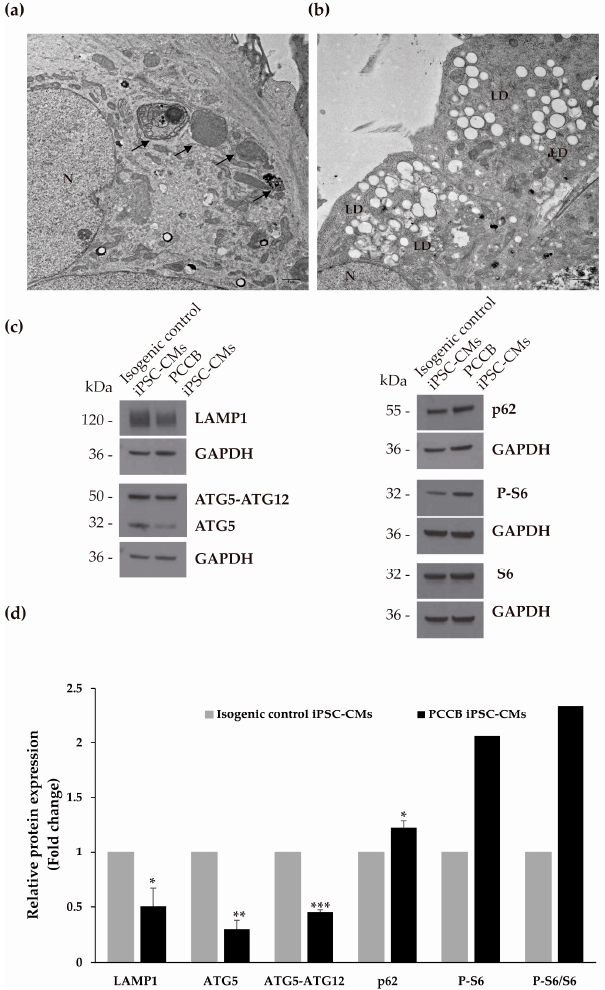
Figure 4. Analysis of cell ultrastructure and autophagy process in the iPSC-CMs. Representative images of EM were shown of isogenic control ( a ) and PCCB ( b ) iPSC-CMs at 3000x magnification. Black arrows show degradation vesicles ( a ). LD: lipid droplets ( b ). N: cell nucleus ( a , b ). Scale bar: 1 µm. ( c ) Representative blot of the protein analysis of LAMP1, ATG5-ATG12 conjugate, ATG5, p62, S6, and P-S6 (its phosphorylated form). GADPH was used as the loading control. ( d ) The corresponding quantification by laser densitometry is shown as the mean ± standard deviation of at least three experiments. In S6 and its phosphorylated form analysis, two experiments were performed (mean 0.9 and 2.06, respectively). Statistical significance was determined by Student’s t -test. * p < 0.05; ** p < 0.01; *** p <